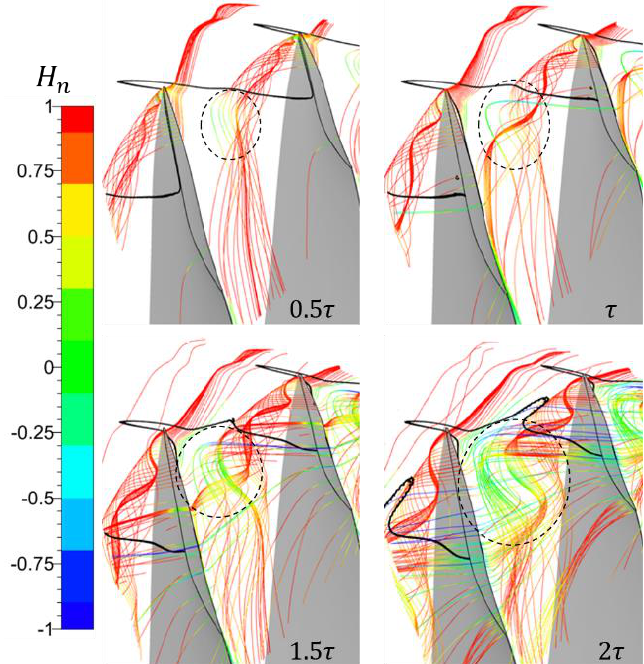
Figure 9. Three-dimensional leakage flow streamlines near the rotor blade LE at